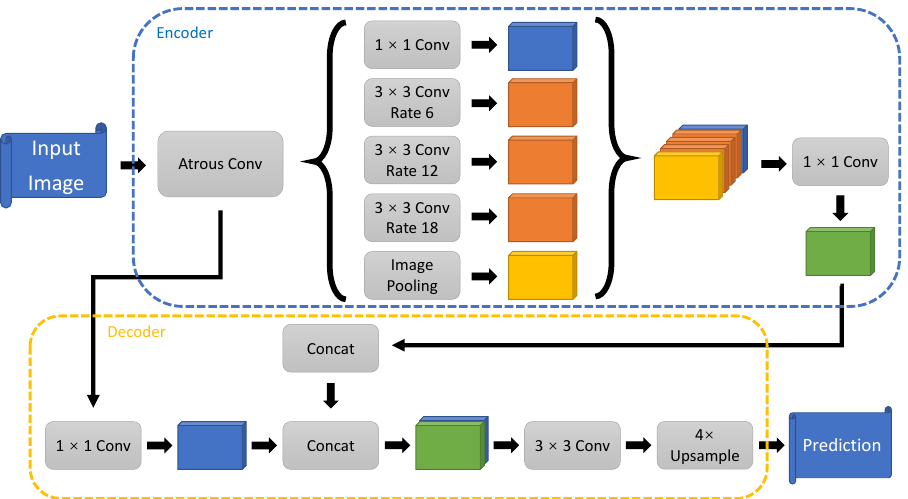
Figure 2. A high-level illustration of DeepLabv3+. The general structure is an atrous convolution, followed by atrous pyramid pooling, with results from both layers concatenated and both used as inputs to the final